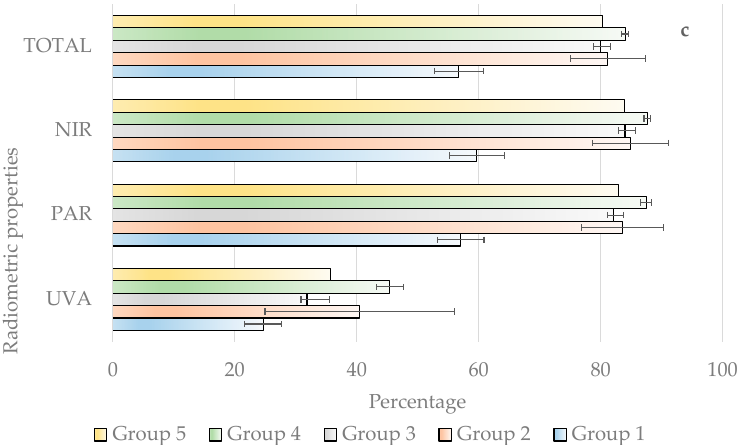
Figure 6. Mean values corresponding to the five classification groups established by multivariate statistical analysis of all ( a ) chemical, ( b ) radiometric and ( c ) mechanical parameters of the polimeric film.